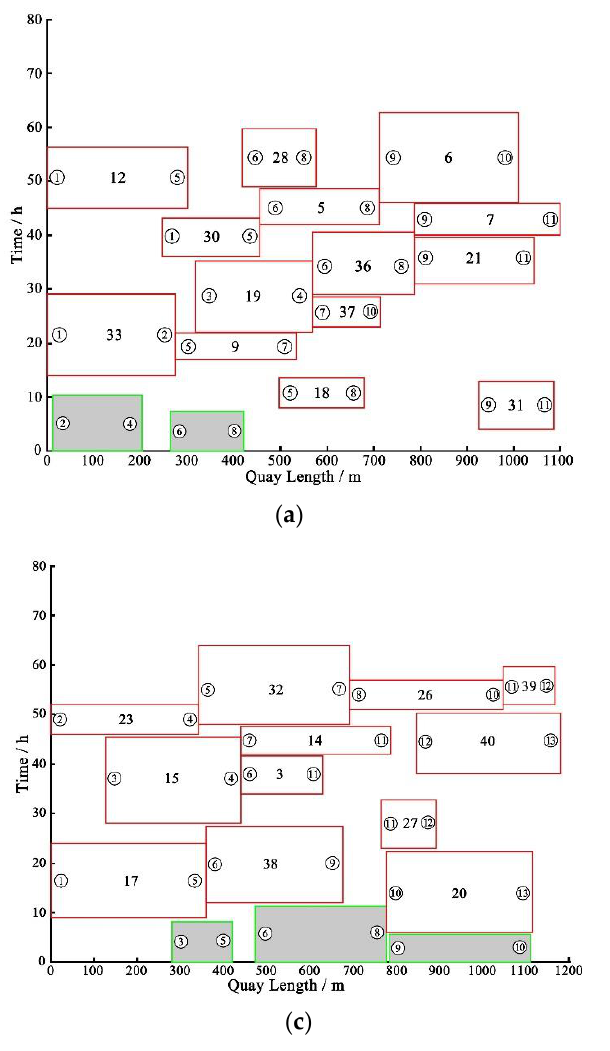
Figure 9. The scheduling solution under M + C. ( a ) terminal 1; ( b ) terminal 2; ( c ) terminal 3. (Source: compiled by authors).